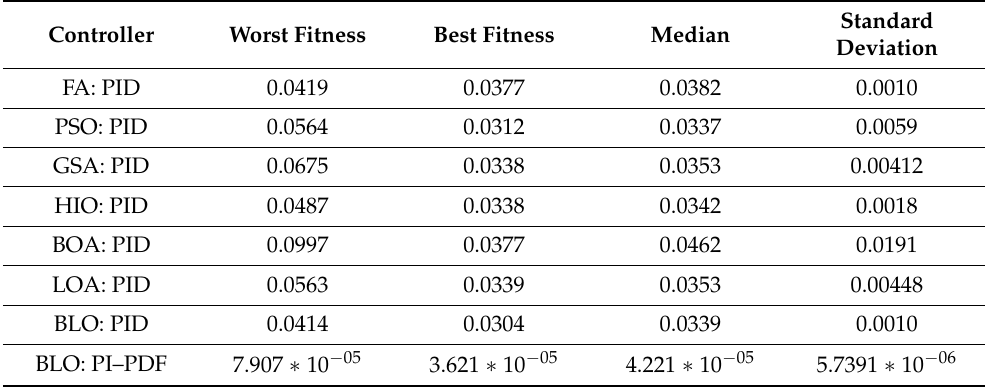
Table 1. Statistical analysis for comparison of optimization